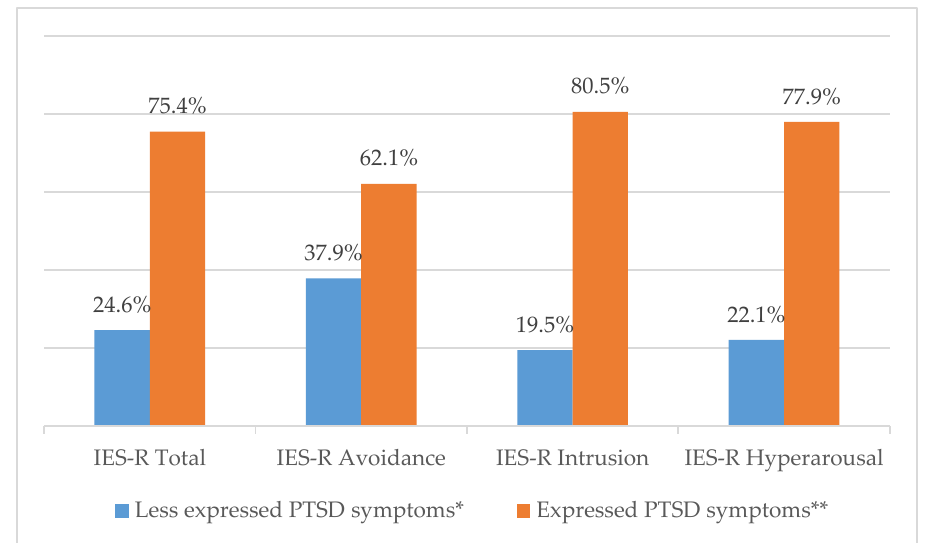
Figure 1. Frequency of post-traumatic stress symptoms (PTSS) among parents of children with cancer. * IES-R mean <1.5; ** IES-R mean ≥1.5.